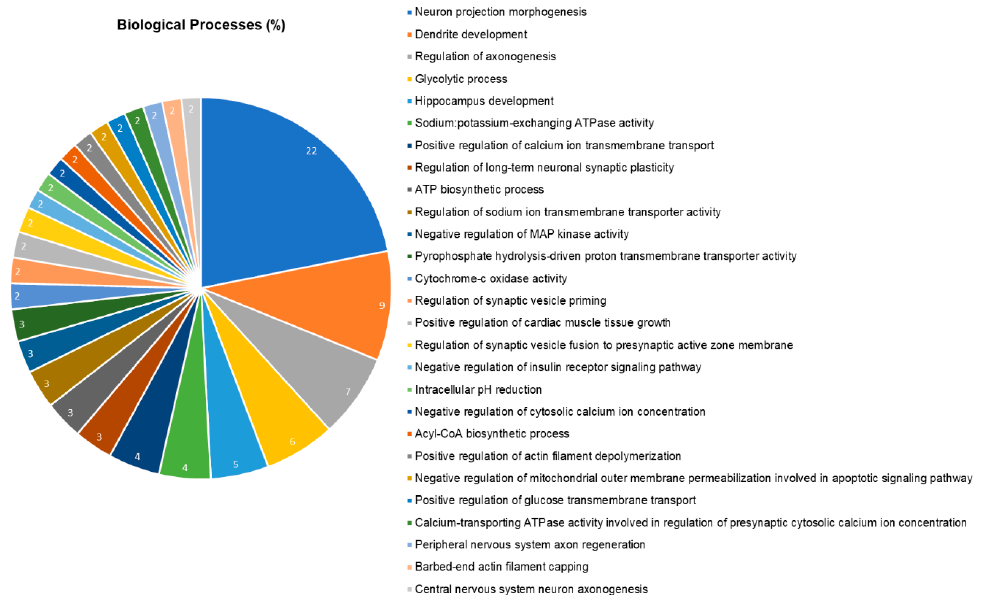
Figure 4. Functional distribution of proteins identified with differential expression in the hippocampus of rats exposed to lead acetate vs. control group. Protein categories based on Gene Ontology annotations on biologic processes. Significant terms and distribution according to the percentage of the number of genes. Protein access numbers were provided by UNIPROT. Genetic ontology was evaluated according to ClueGO plugin ® Cytoscape Software ® 3.6.